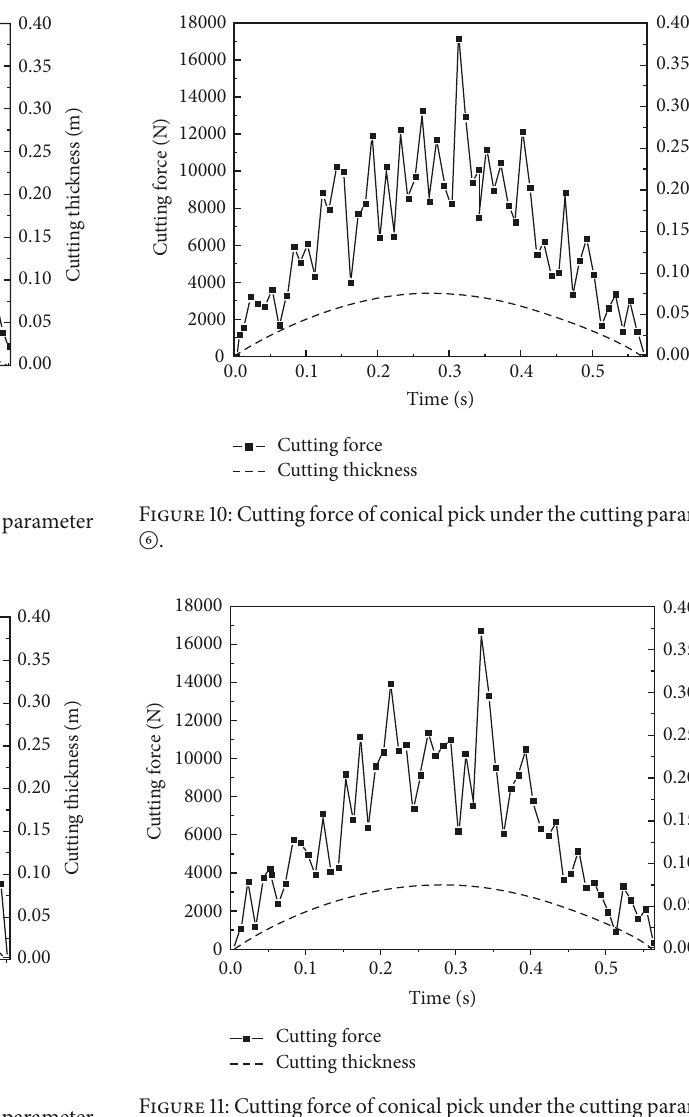
Figure 9: Cutting force of conical pick under the cutting parameter E .